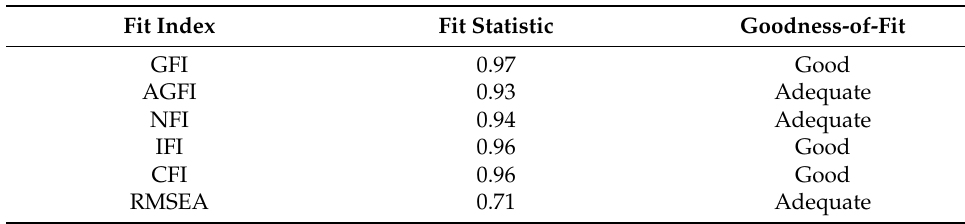
Table 5. Fit indices of final